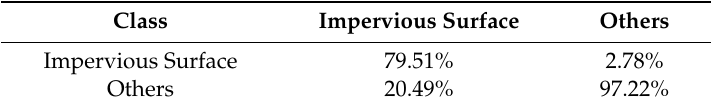
Table 9. Confusion matrix of construction on the image after